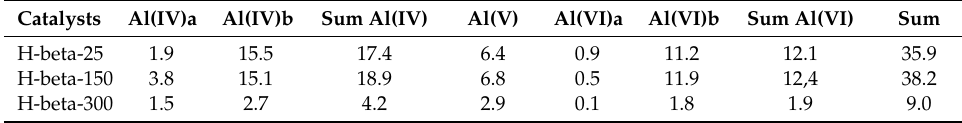
Table 3. Line intensities in 27 Al-MAS NMR spectra from H-beta-25, H-beta-150, H-beta-300